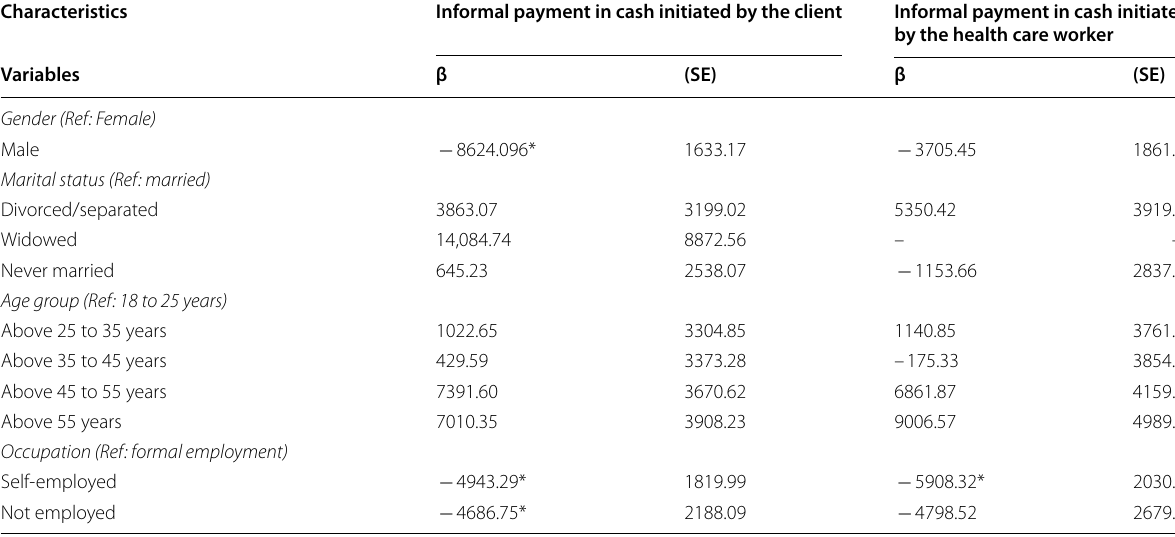
Table 5 Determinants of informal payments using the Tobit regression